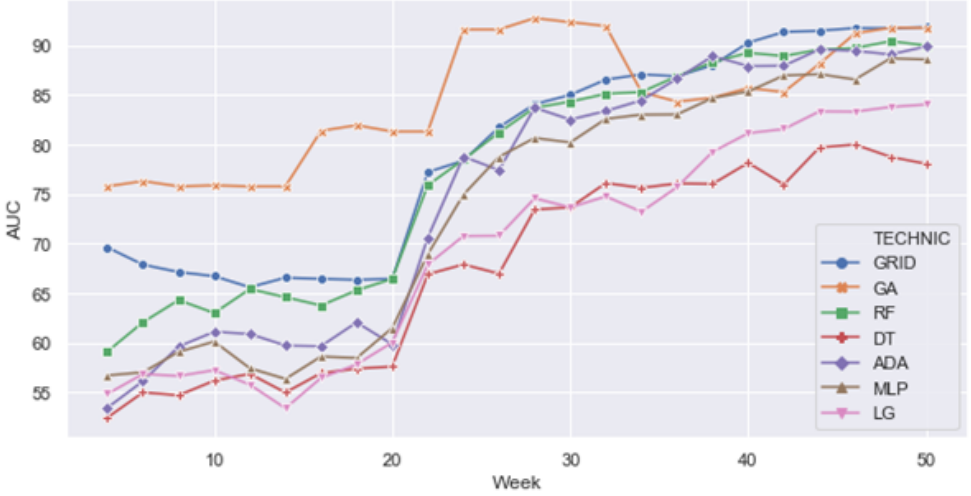
Figure 6. AUC results for each tested technique during the 50 weeks of the